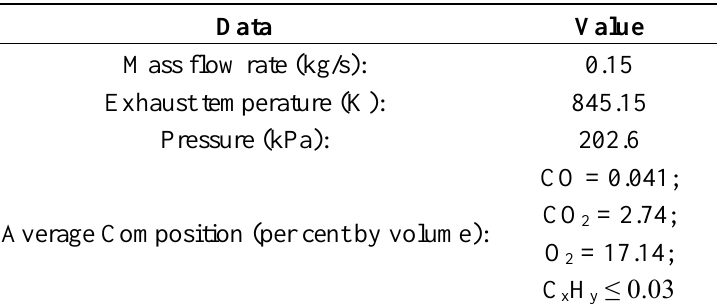
Table 1. Thermal source main data.